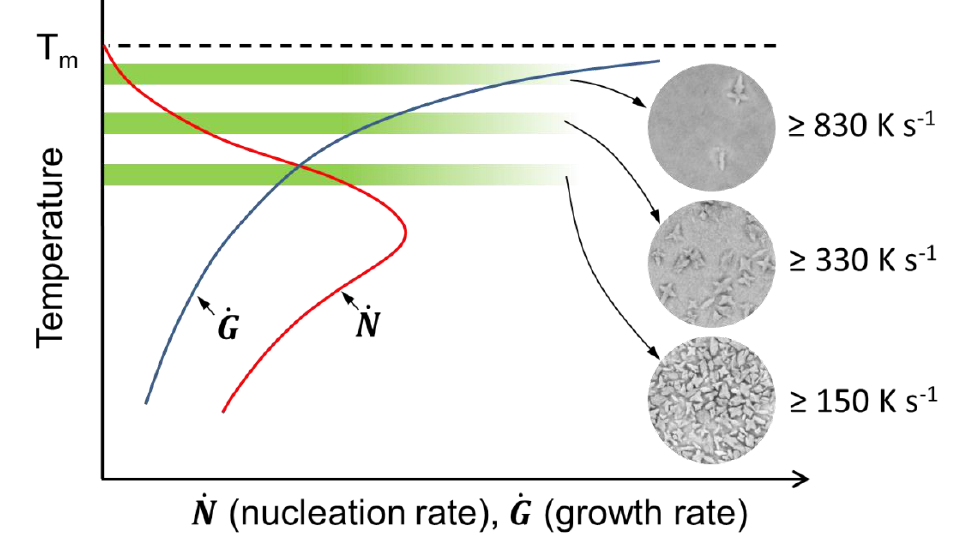
Figure 4. Schematic illustration of annealing conditions of the samples selected for the current study. Nucleation and growth rate curves are drawn based on reference [41].